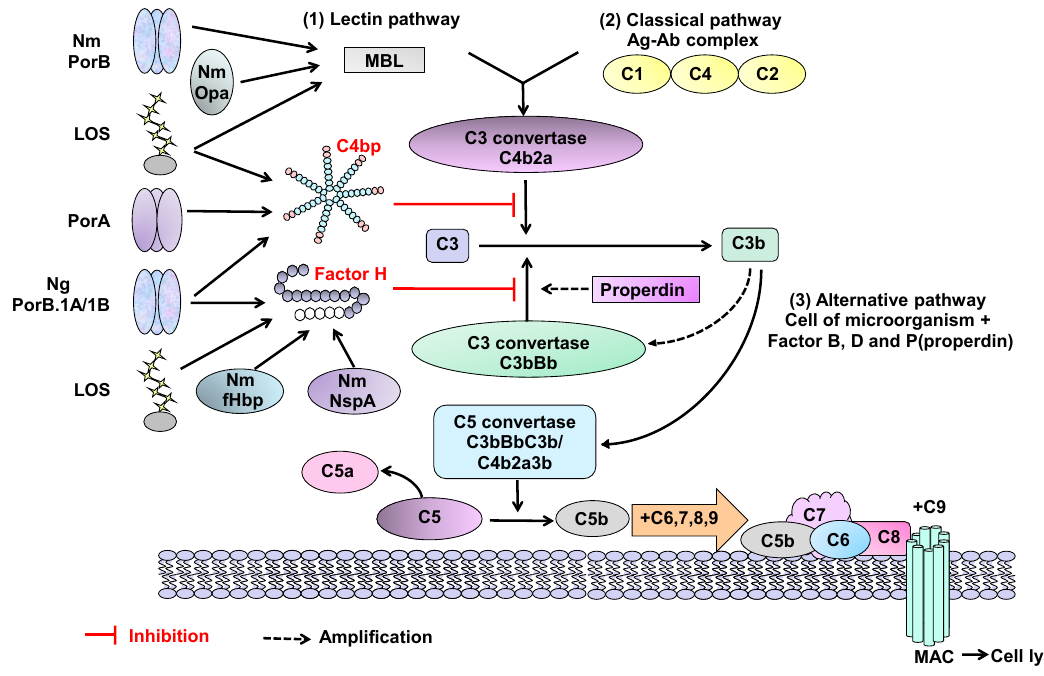
Figure 2. Interaction of Neisserial surface molecules with the complement system. The interactions of Neisseria molecules with components of the human complement system can have inhibitory or stimulatory effects. (i) Lectin pathway activation: binding of meningococcal (Nm) Opa and PorB proteins by MBL (mannose-binding lectin) is a possible mechanism that accelerates complement activation and increases bacterial killing. The core structure of LOS can also bind MBL, but binding is reduced following LOS sialylation; (ii) Classical pathway down-regulation: Nm PorA, gonococcal (Ng) PorB.1A and PorB.1B and LOS can also bind C4bp (complement regulatory protein C4b-binding protein), which is the main inhibitor of the classical pathway; (iii) Alternative pathway down-regulation: Nm fHbp and NspA, LOS and Ng PorB.1A and PorB.1B bind to complement-inhibitory regulator serum factor H and down-regulate the alternative pathway. Gonococcal strains expressing PorB.1A bind factor H (and/or C4bp) avidly, whereas strains expressing PorB.1B bind factor H weakly. However, sialylation of LOS increases binding of PorB.1B to factor H. The binding of some strains expressing PorB.1B to C4bp can occur regardless of LOS